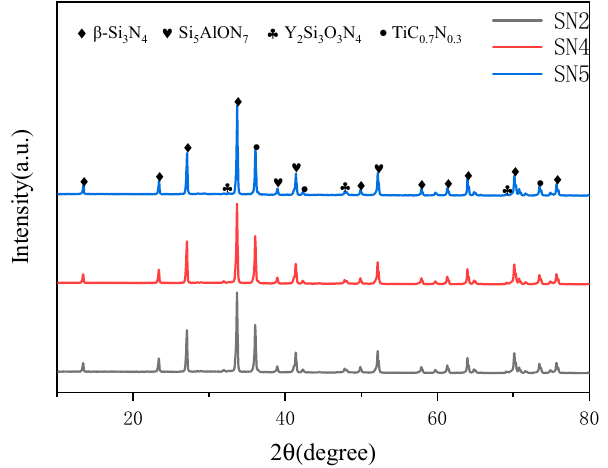
Figure 7. XRD patterns of samples at different hot-pressing temperatures: The sintering temperatures of SN2, SN4, and SN5 samples were 1650, 1700, and 1750 °C, respectively.